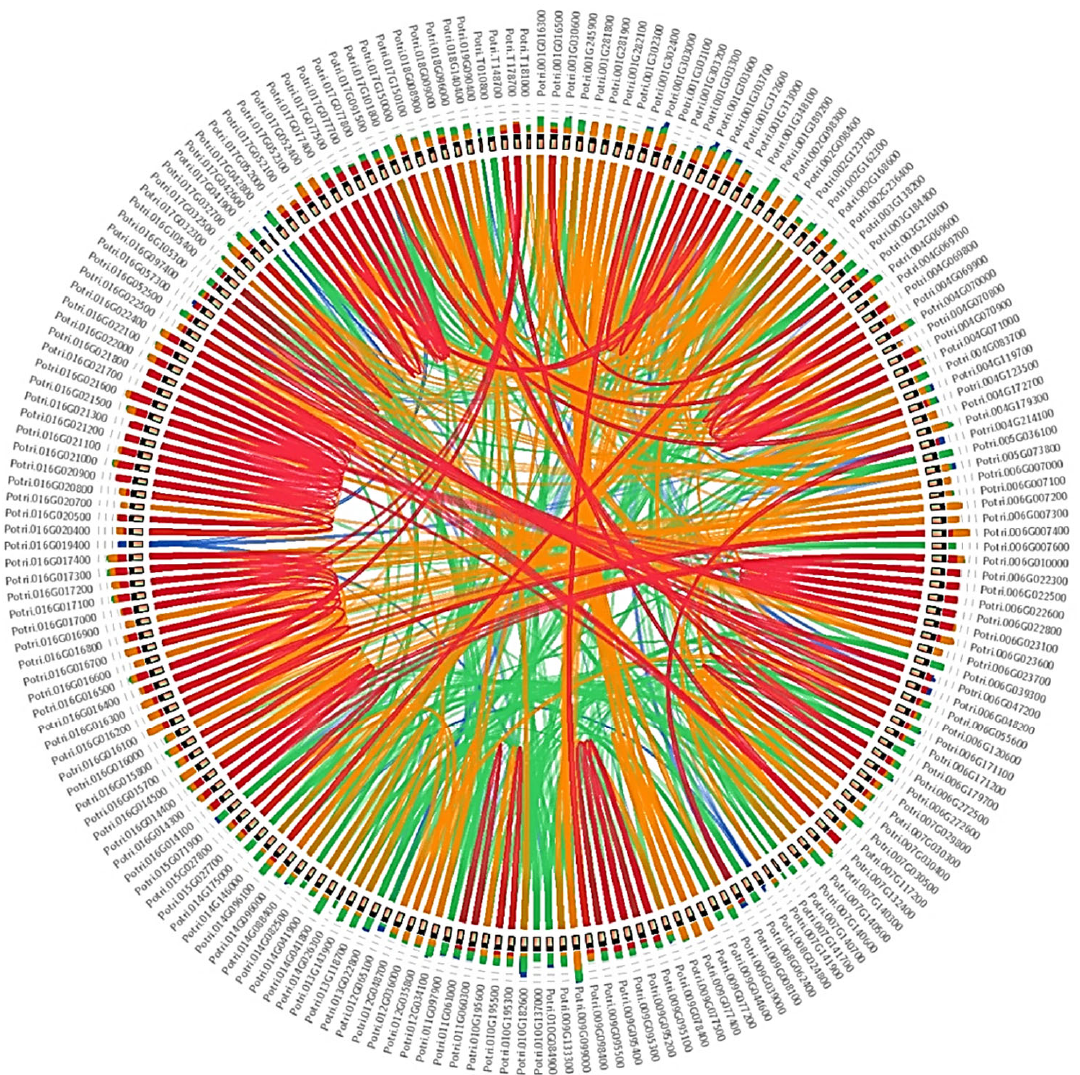
Figure 4. Syntenic analysis of 191 UDP glycosyltransferases (UGTs) in Populus . Different color threads show the duplication of genes among all UGTs presented.